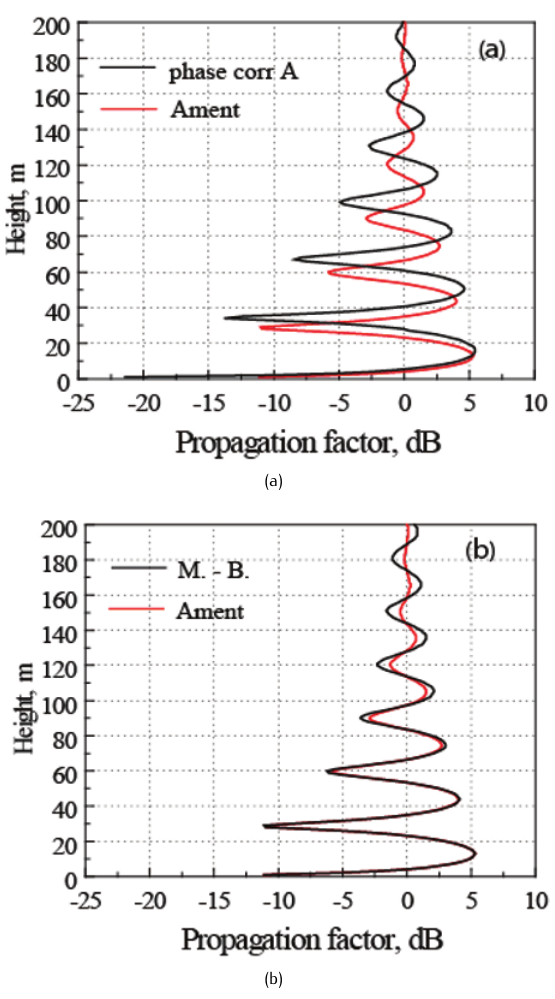
Figure 4. Comparisons between PFs obtained with original Ament and phase corrected Ament RRF, (a), and original Ament